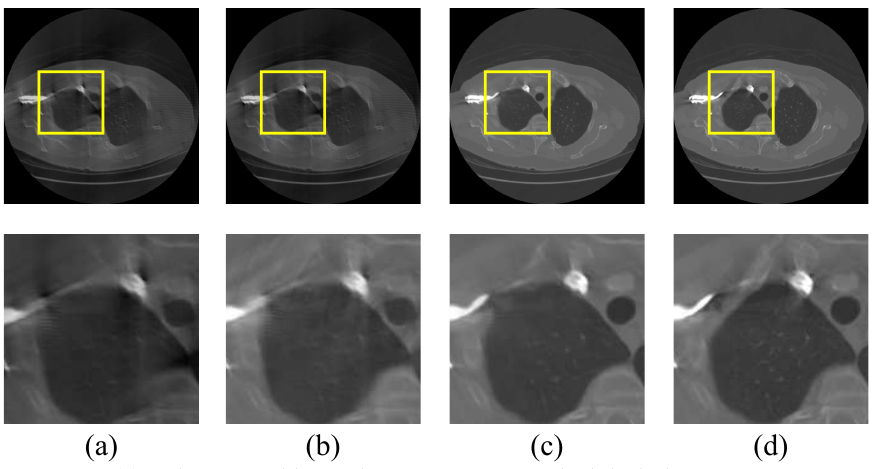
Figure 10. ( a ) is the original limited-view CT image, which lack the post 60 projection views (the corresponding full-view CT has 180 projection views); ( b ) is the CT reconstruction result of the first stage; ( c ) is the CT reconstruction result of the second stage; ( d ) is the ground truth CT